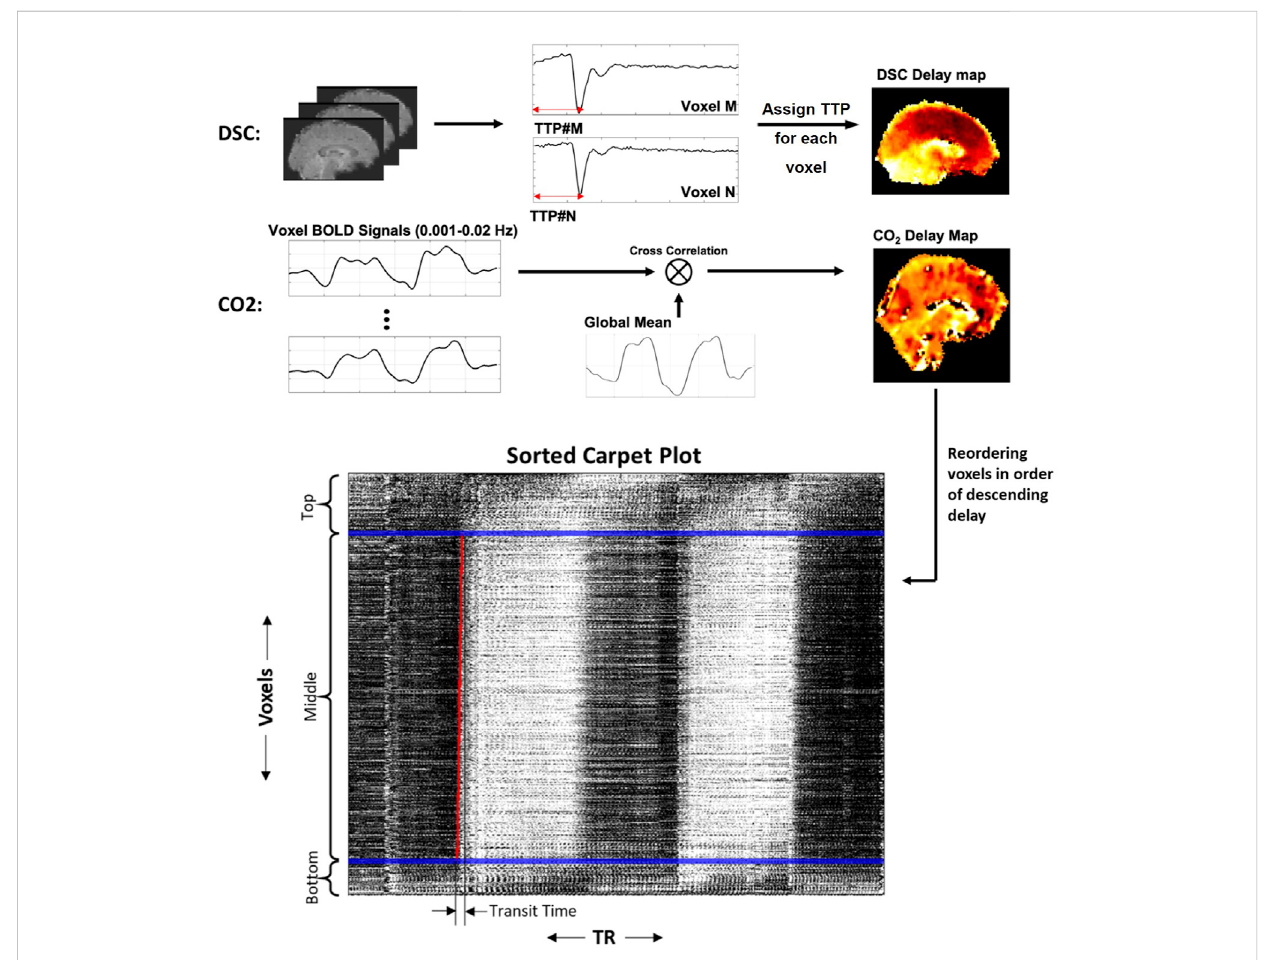
FIGURE 1 Methods for creating DSC delay maps, CO 2 delay maps and carpet plots. DSC delay maps were created by computing the voxel-wise time to peak (TTP) metric, representing the delay until peak signal decrease was obtained, which corresponds to the arrival of the gadolinium bolus in a given voxel. CO 2 delay maps were computed by performing voxel-wise cross-correlation between individual voxel time series and the global averaged time series and selecting the delay value which resulted in maximum absolute correlation. Voxels were then sorted in descending order according to the computed delay values, and the 2D carpet plot image was created by displaying the time series of all brain voxels in this sorted order (top representing largest delay, bottom representing smallest